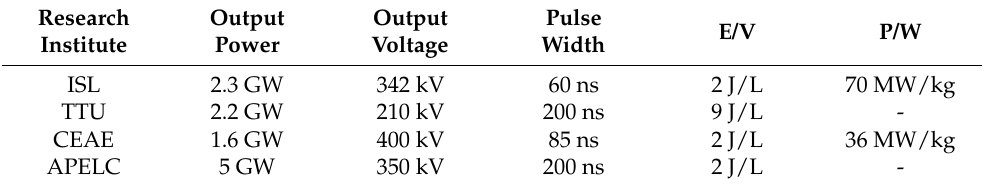
Table 1. The parameters of the typical compact pulse forming network (PFN)-Marx generators. Research Output Output Pulse E/V Institute Power Voltage Width